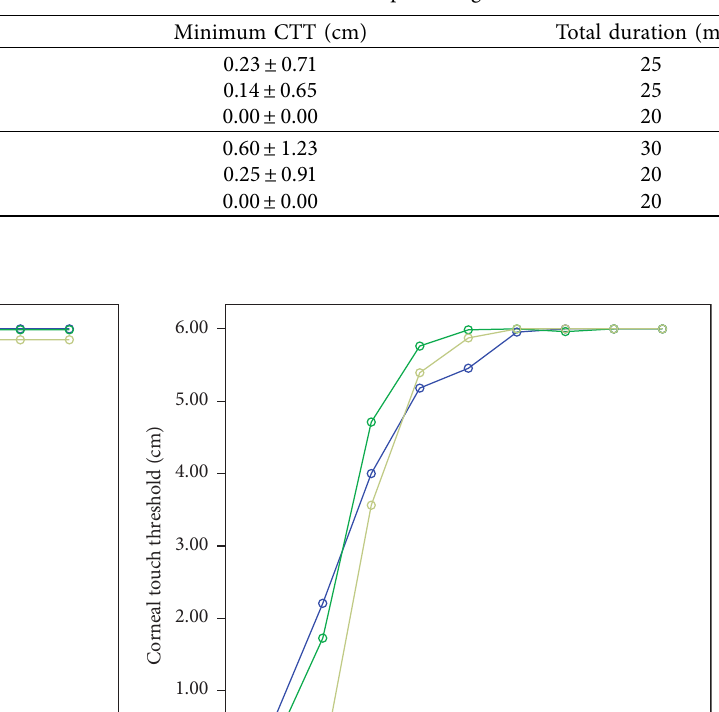
Table 1: Minimum CTT values and total duration of effect with respect to age.